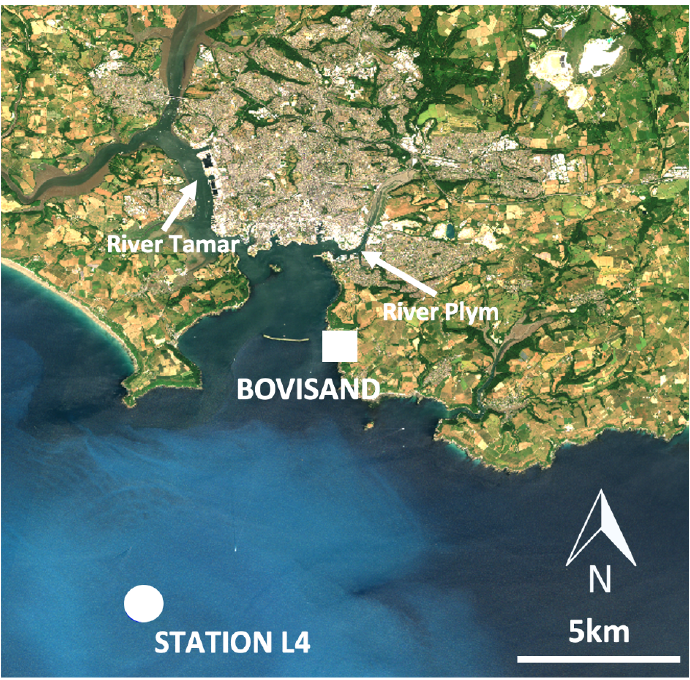
Figure 1. Study site map showing nearshore (Bovisand Beach), and offshore (Station L4) coastal locations sampled in this study. Image taken by Sentinel-2 satellite on 29 June 2018. Chalky white appearance in water offshore suggests the presense of